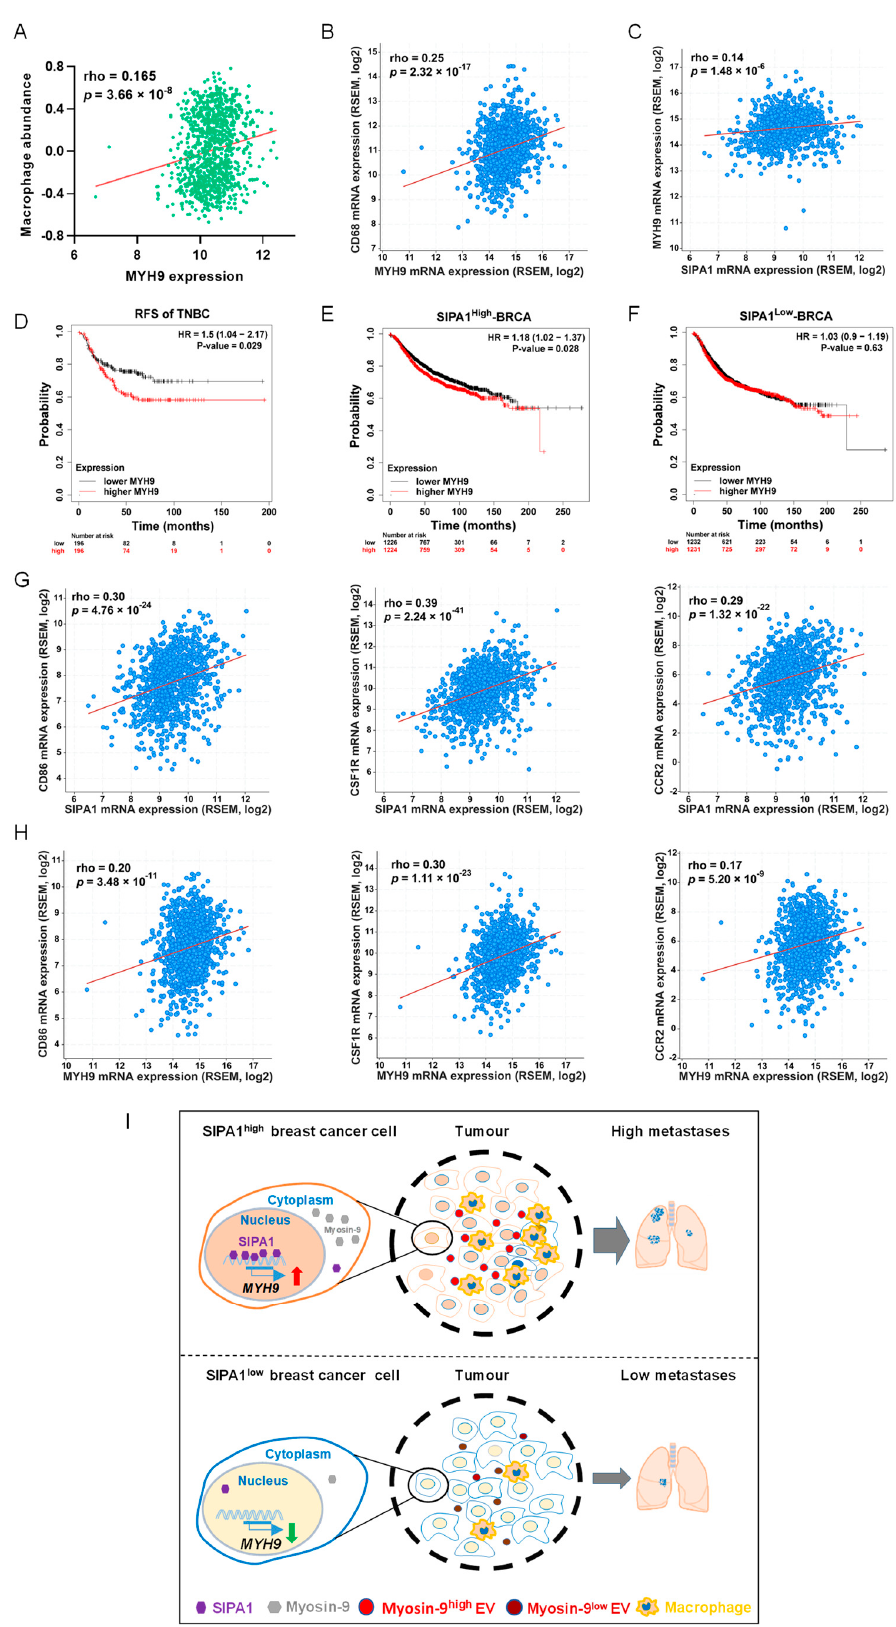
Figure 6. MYH9 is a poor prognosis predictor of triple-negative breast cancer. ( A ) The correlation between SIPA1 expression and macrophage abundance based on the TISIDB database (n = 1100).